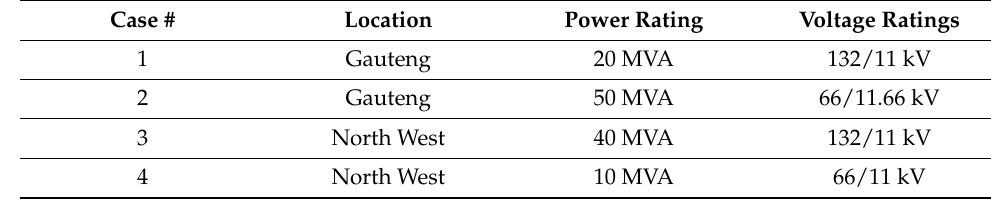
Table 2. Case studies under investigation.